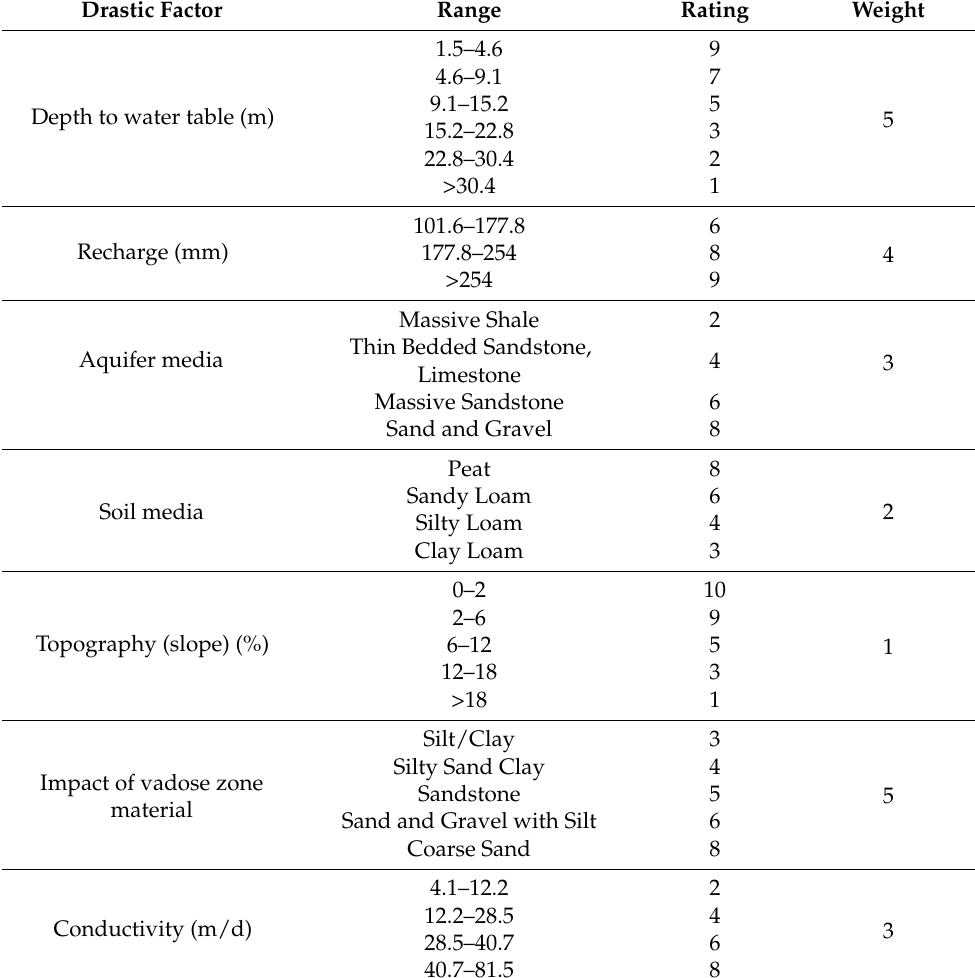
Table 2. Classification and weighting results of different parameters of hydrogeological factors according to the DRASTIC classification and weighting